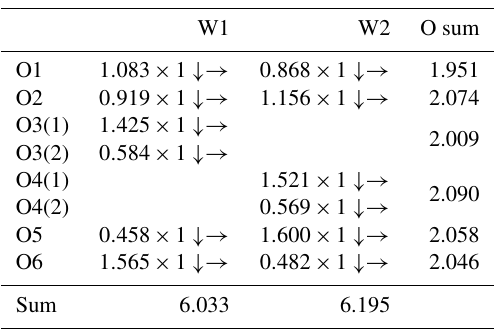
Figure 10 shows electron diffraction patterns of the [010] and [10–1] zone axes of liguowuite. Using space group P 2 1 /n (no. 14) and the monoclinic cell parameters, all of the in- tense reflections in the directions of the [010] and [10–1] zone axes were successfully indexed and are consistent with the electron diffraction simulation. Most of the reflections accord with the systematic absence condition of glide plane n ( h + l (cid:54)= 2 n ( k = 0)). The presence of several weak reflec- tions with h + l (cid:54)= 2 n in the SAED pattern and the absence of these types of reflections in the PXRD pattern (Fig. 6) indicate short-range ordering in the liguowuite structure, but generally the structure is in agreement with the P 2 1 /n model. Based on the indexed data, d (200) = 0.37126 nm, d (020) = 0.37586 nm, and d (002) = 0.38682 nm were ob- tained, so the calculated axis lengths based on the elec- tron diffraction data are a = 0.74252 nm, b = 0.75174 nm, and c = 0.77365 nm, which are close to those obtained from the powder crystal refinement. The lattice fringes of the liguowuite with spacings of 0.3773 and 0.4375 nm, which correspond to the { 020 } and { 111 } planes, respectively, were observed using high-resolution TEM (Fig.